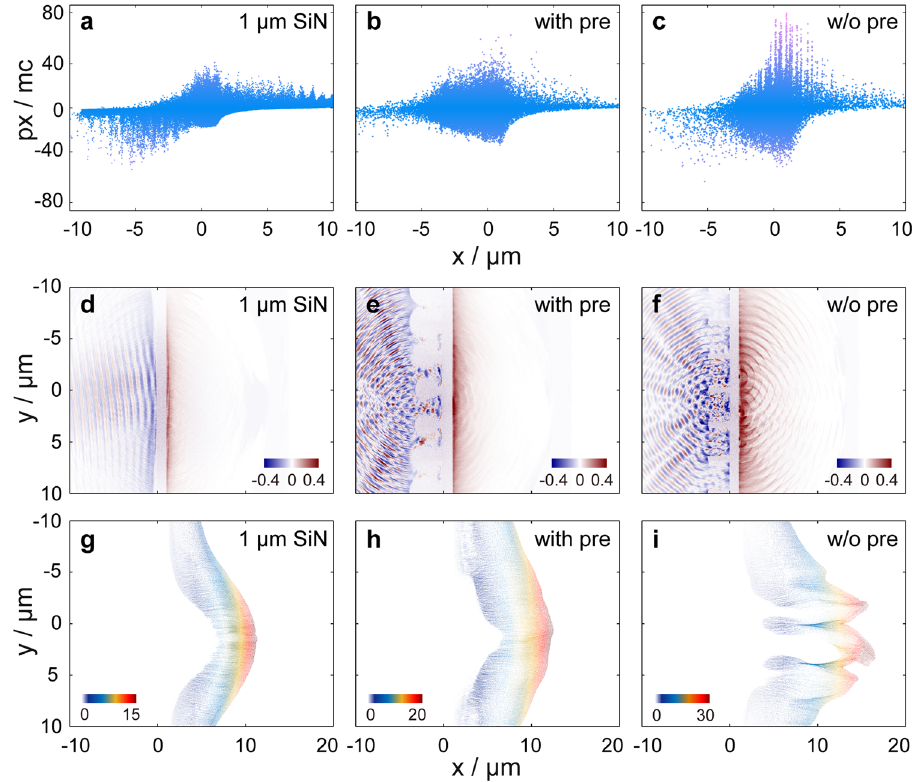
Fig. 5 The Comparison of proton acceleration processes under different target conditions. The phase space distribution of electrons for 1 μ m planar target ( a ) and p = 3.3 μ m microwire array (MWA) target with pre-plasma ( b ) and without pre-plasma ( c ). d – f The distribution of longitudinal electric fi eld E x . The fi elds are normalized to the incident laser electric fi eld E 0 = 4.1 × 10 13 V m − 1 . g – i Proton energy (MeV) distribution at t = 300